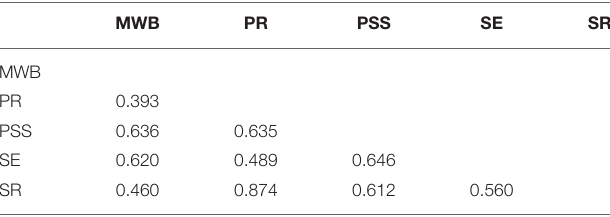
TABLE 3 | Discriminant validity heterotrait–mono trait ratio.